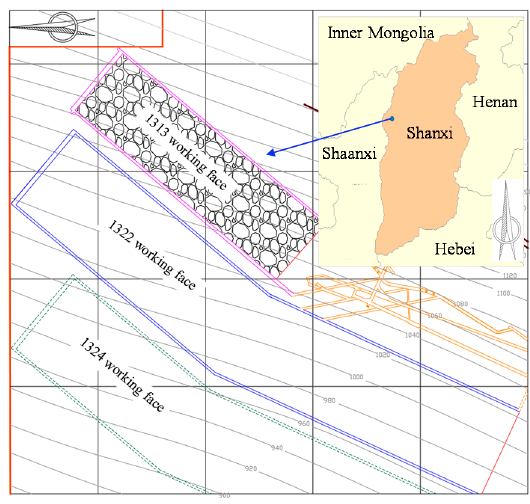
Figure 1. Layout and location of working face 1313.